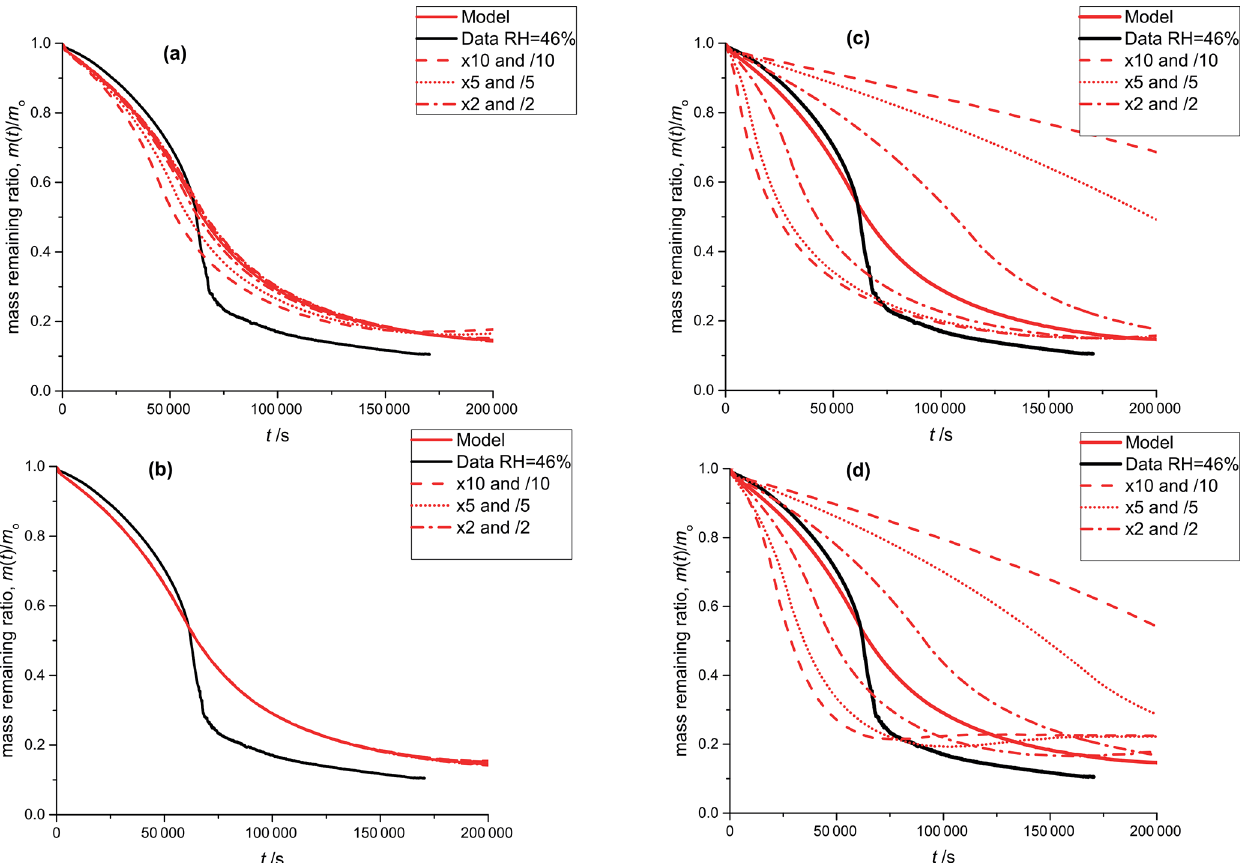
Figure A3. Black: mass remaining data versus time of the photodegradation experiment discussed in Sect. 3.1; RH 46%. Red lines: model outputs obtained by varying a single parameter with factors: 10 and 0.1 (dashed), 5 and 0.2 (dotted), 2 and 0.5 (dash-dotted), 1 (solid). In panel (a) , the equilibrium constant of E8 is varied and in panel (b) the equilibrium constant of equilibrium E5 is varied. Panel (c) shows the sensitivity to the reaction constant (Reaction R9, see Table 2) and panel (d) shows the sensitivity to oxygen diffusivity (Table 1).